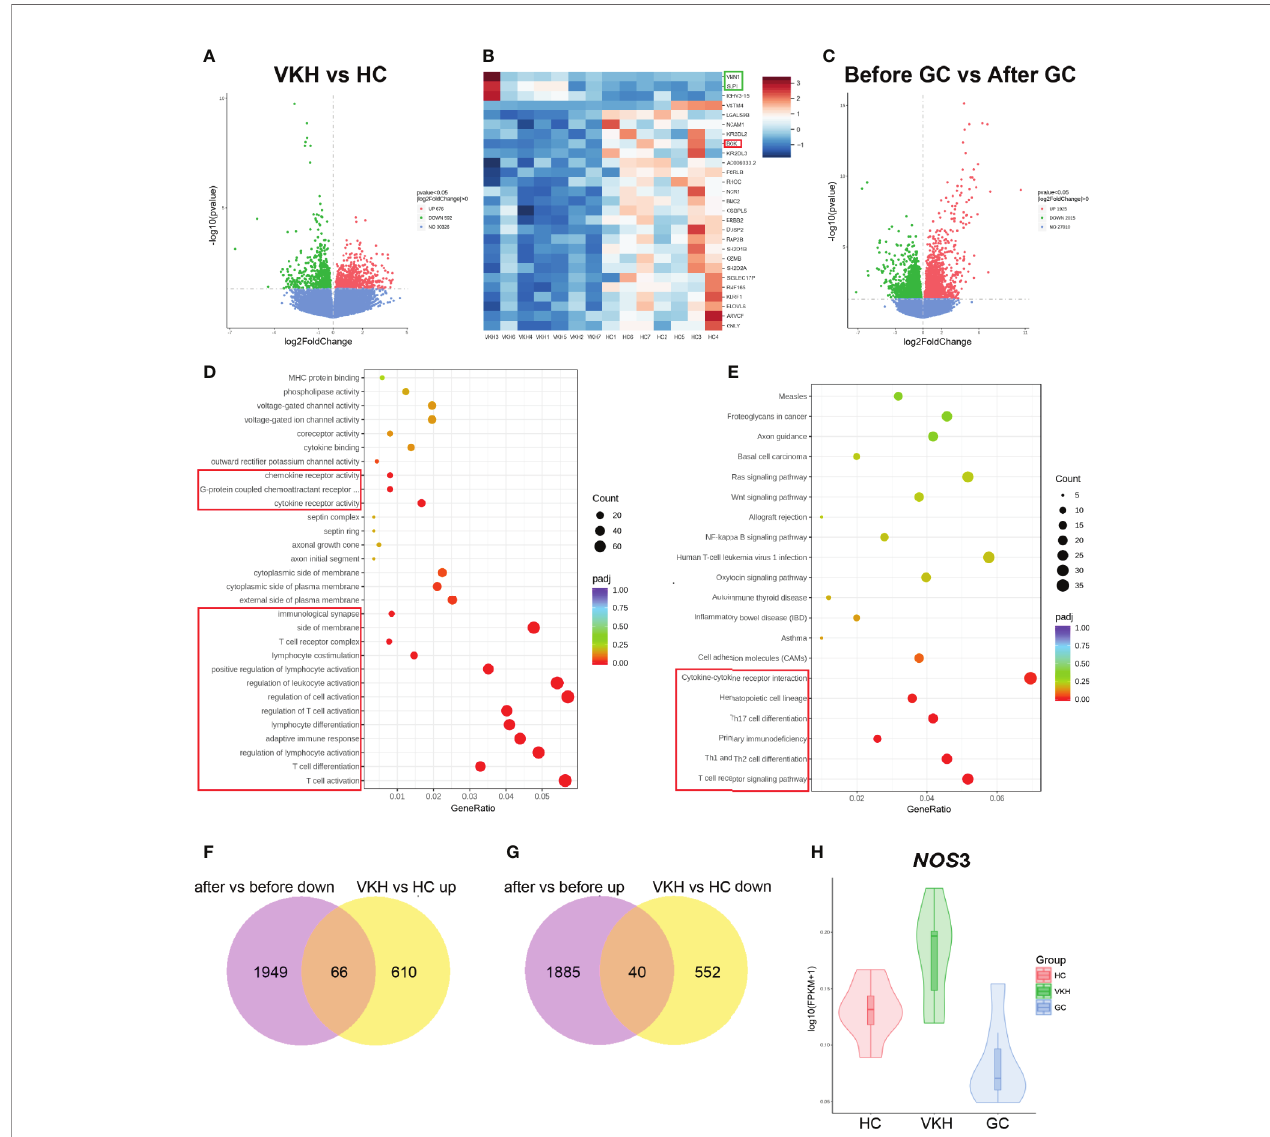
FIGURE 9 | Gene expression in the peripheral blood from VKH patients before (before, n=7) and after (after, n=7) GC treatment for one week, as well as healthy controls (HC, n=7). (A) Volcano plots illustrating the differential RNA expression levels between VKH patients and healthy controls. (B) Heatmap shows differentially expressed genes in VKH patients and HCs. (C) Volcano plots illustrating the differential RNA expression levels between patients before and after GC treatment. Functional enrichment analysis revealing differentially expressed genes in VKH patients before and after GC by KEGG (D) and GO enrichment (E) . (F) Genes up- regulated in VKH and down-regulated after GC therapy. (G) Genes down-regulated in VKH and up-regulated after GC therapy. (H) Violin plot of NOS 3 expression in HCs, VKH patients before and after GC